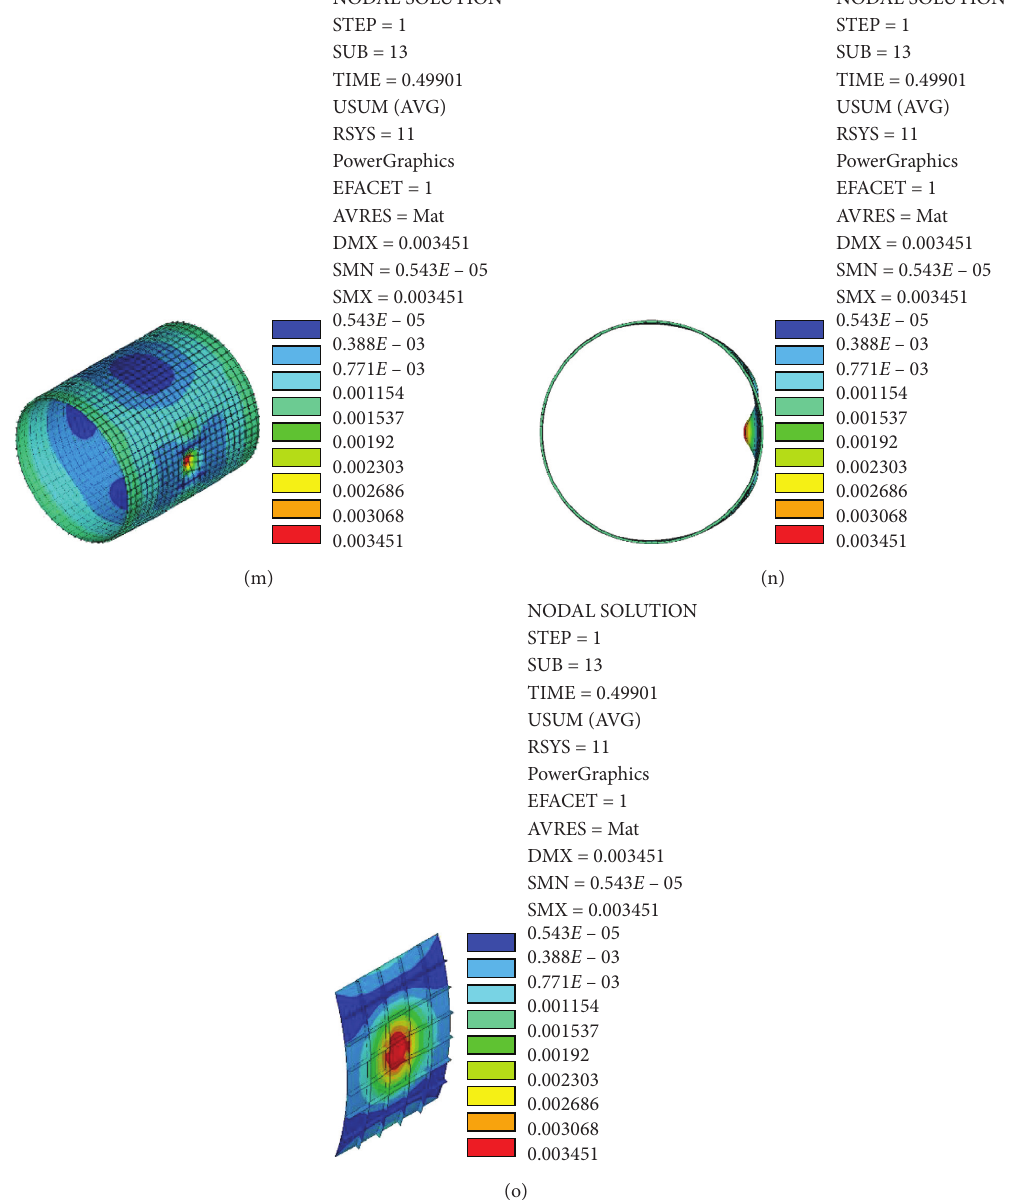
Figure 7: Comparison of buckling modes between the prototype and partial similitude model when λ view of the prototype (10x magnification). (b) Front view of the prototype (10x magnification). (c) Near imperfection of the prototype